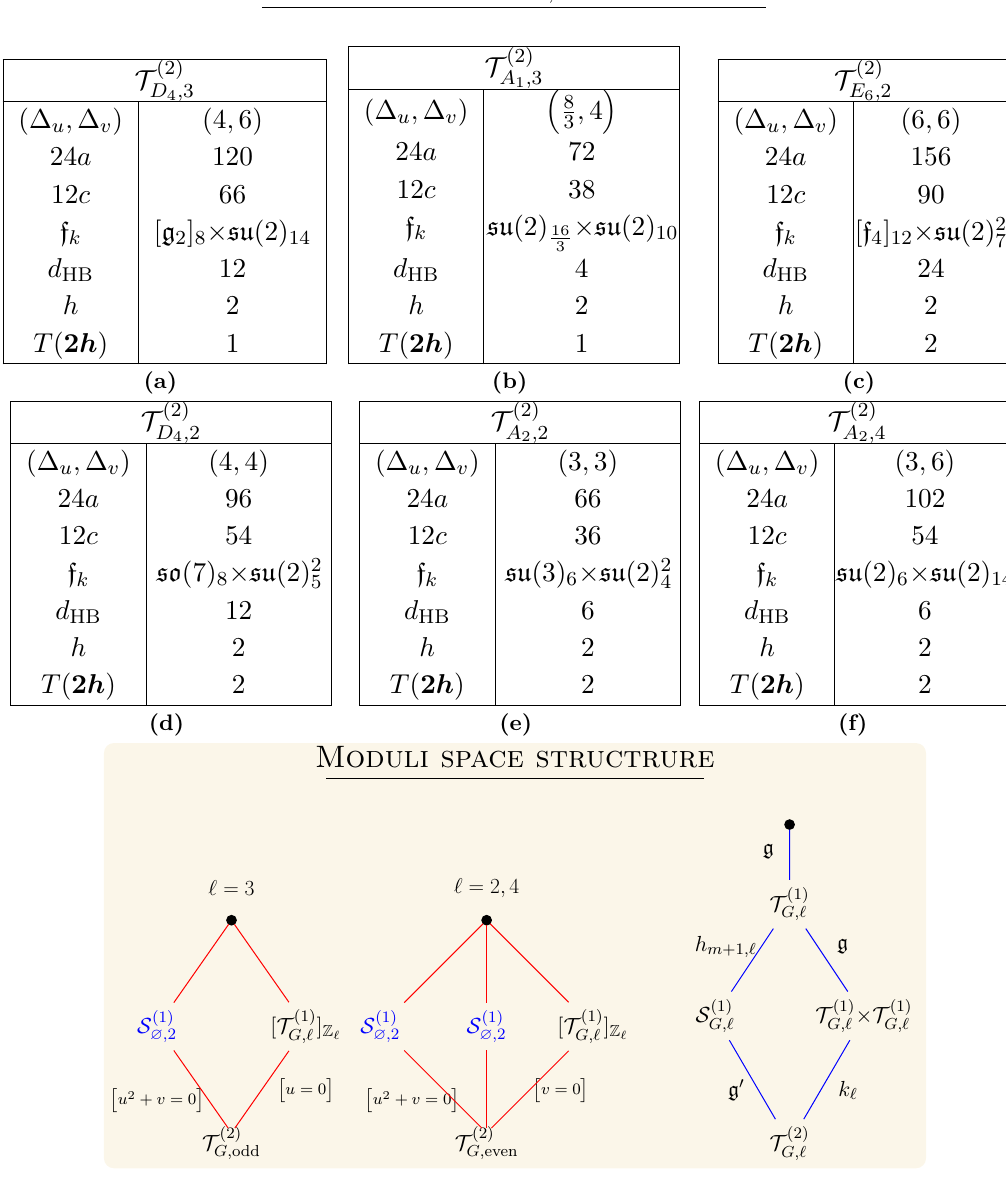
theories where the ( m, g 0 ) G,‘> 1 2) , ( D 3) , ( D 2) , 6 , 4 , 4 ,